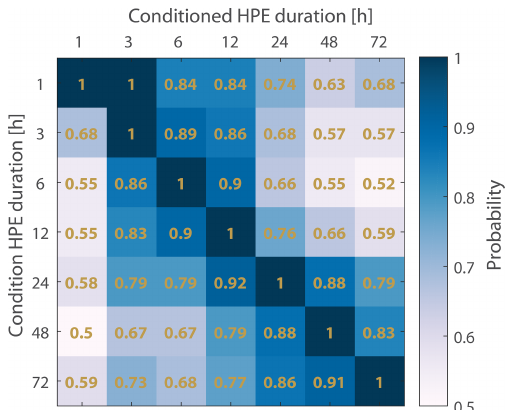
Figure 5. Probability of a HPE with a given examined duration listed on the x axis conditioned on being a HPE with a duration listed on the y